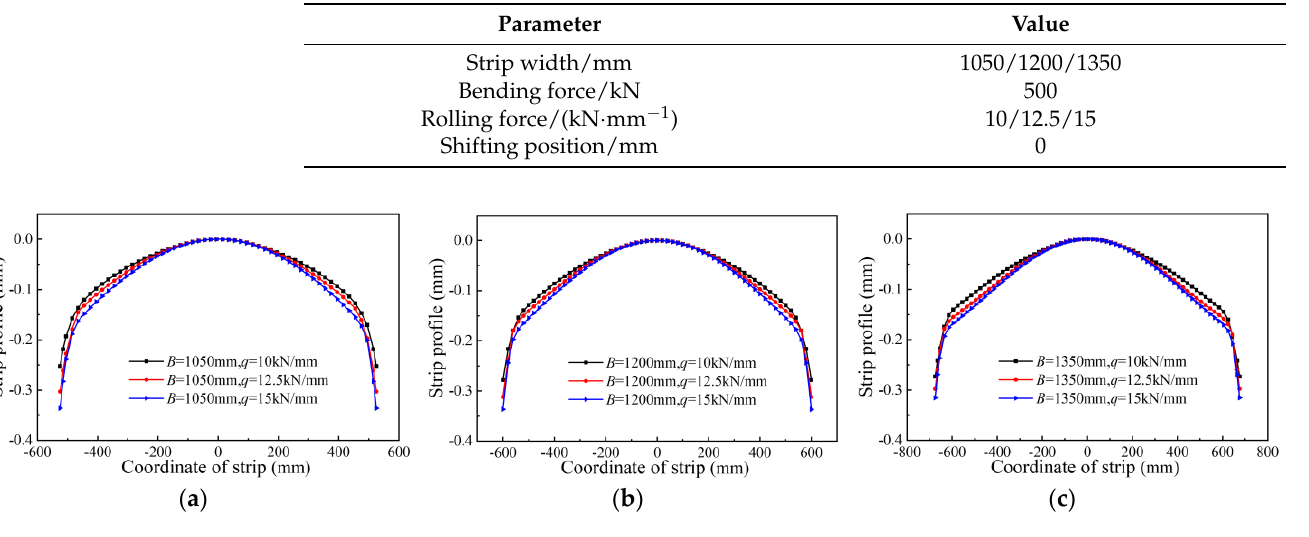
Figure 9. Influence of rolling force on strip crown. ( a ) B = 1050 mm; ( b ) B = 1200 mm; ( c ) B = 1350 mm. Table 9. Results of the influence of rolling force on strip crown.